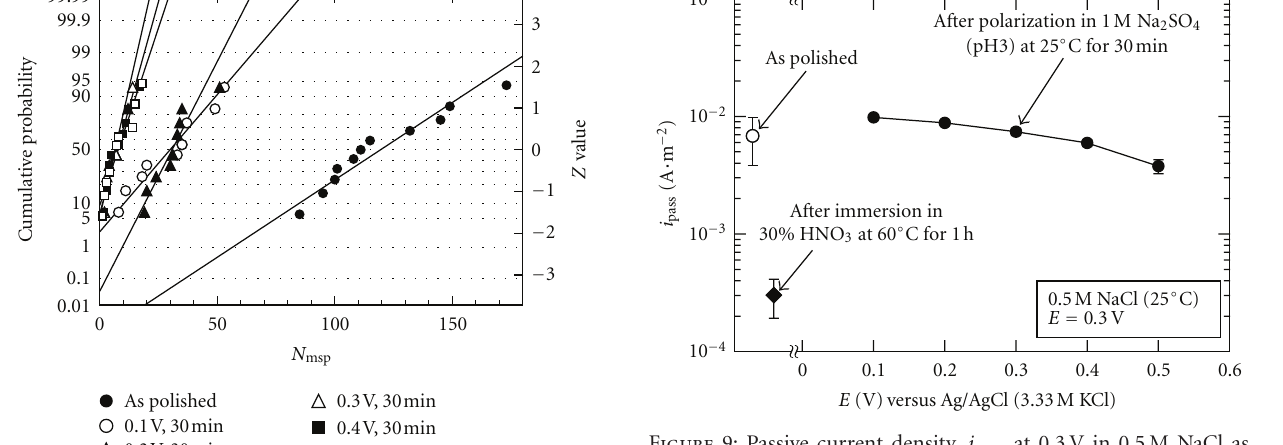
Figure 9: Passive current density, i pass , at 0.3V in 0.5 M NaCl as a function of polarization potential in 1M Na 2 SO 4 of pH 3 for commercial Type 316L stainless steels. The corresponding data for as-polished and HNO 3 passivated steels are shown for comparison. Error bars indicate a standard deviation of i pass